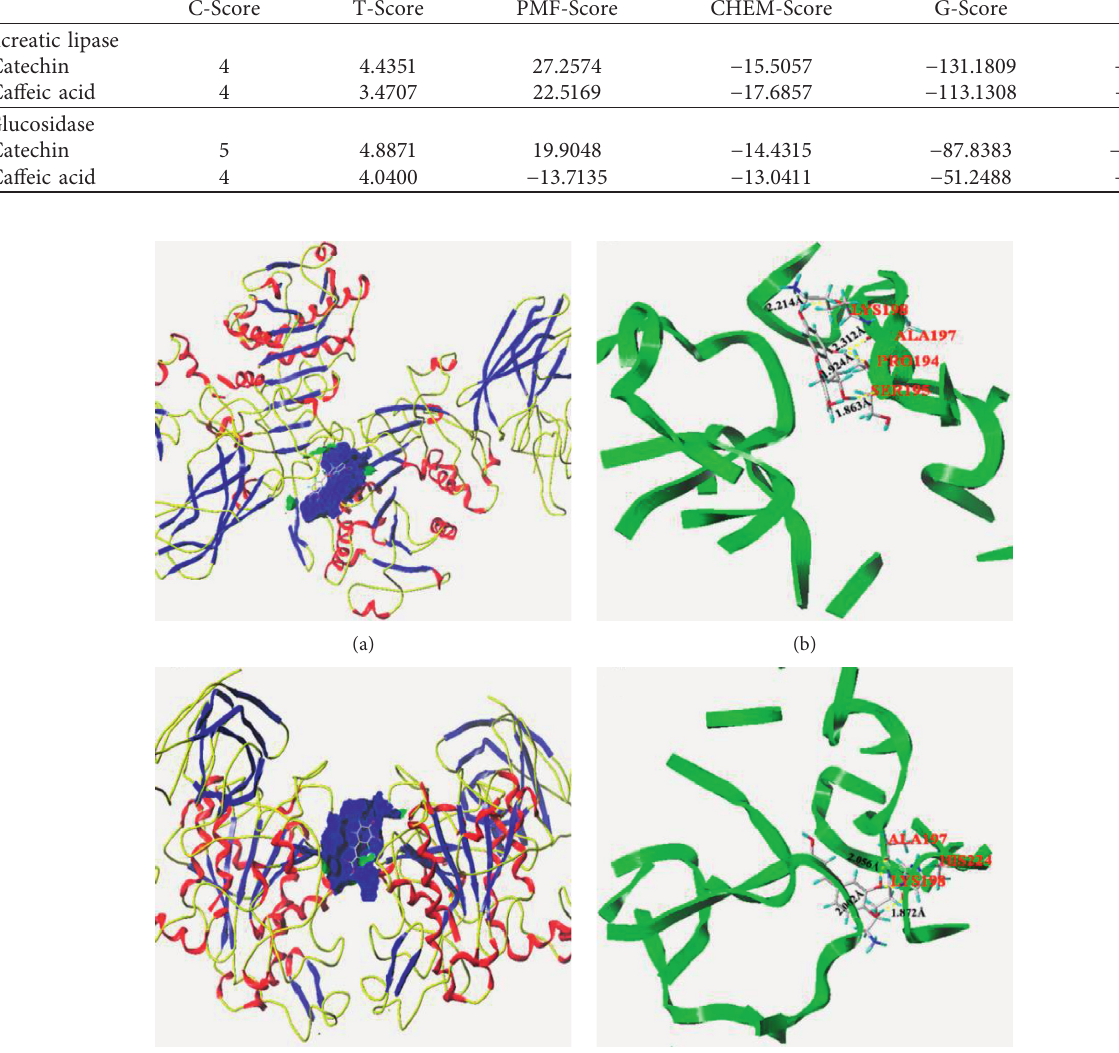
Table 3: The score results of two phenolic compounds docking with pancreatic lipase and α -glucosidase, respectively. C-Score